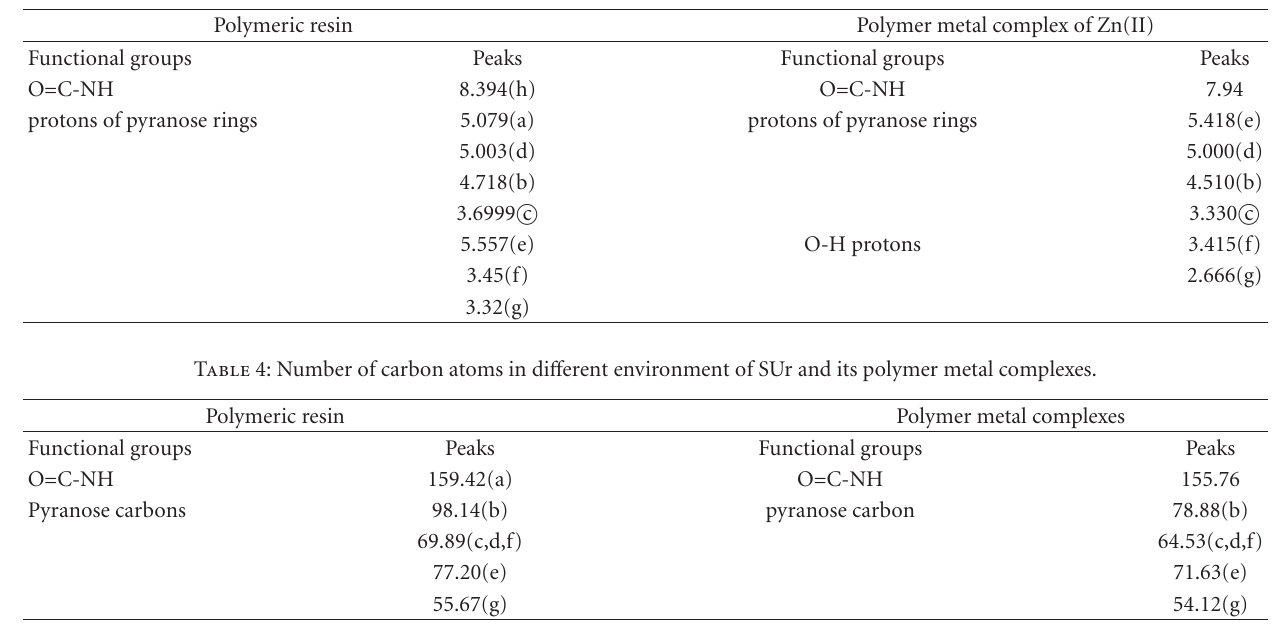
Table 3: Number of protons in di ff erent environment of SUr and its polymer metal complexes